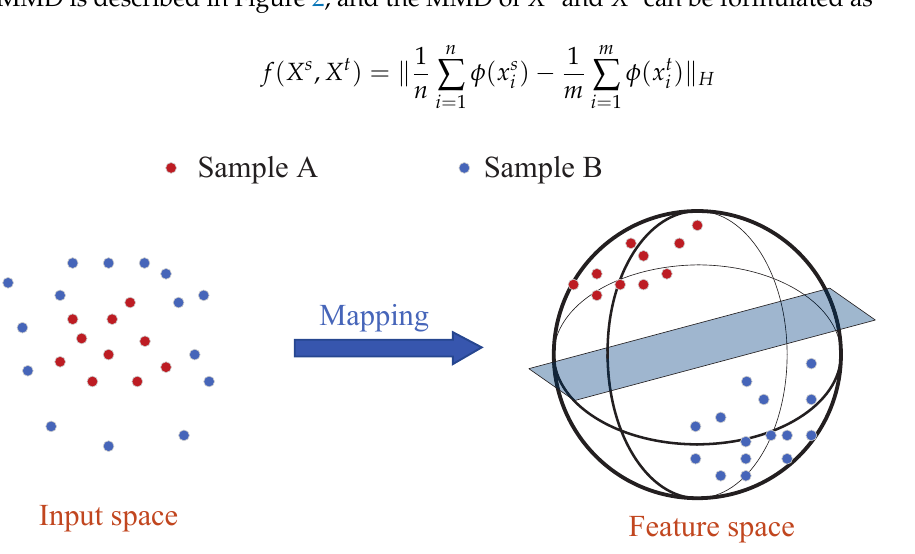
Figure 2. Schematic of Maximum Mean